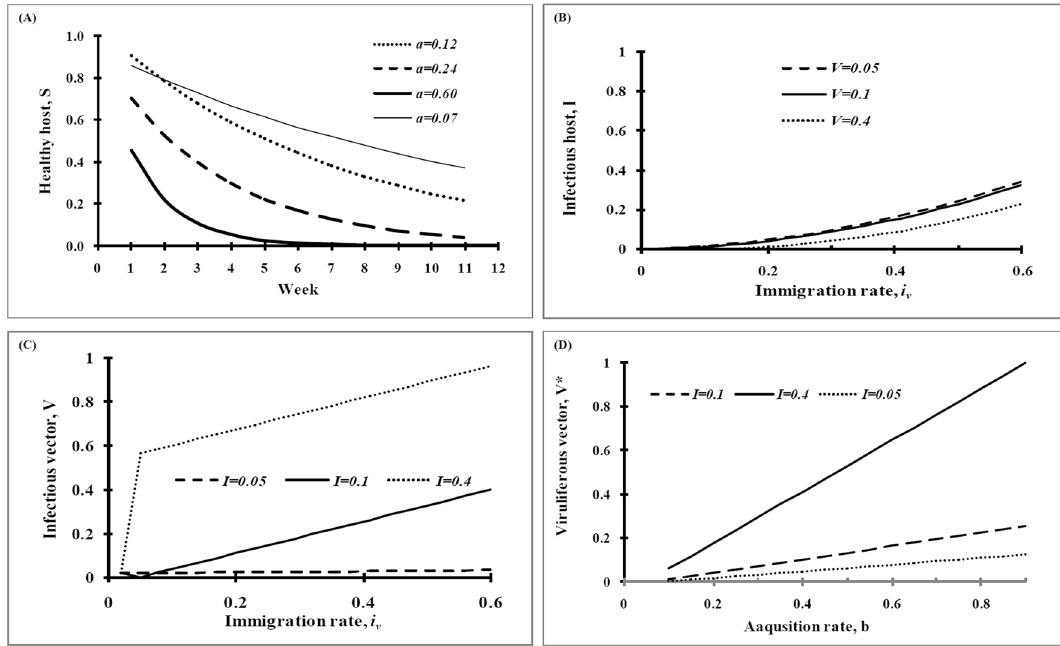
Figure 3. Parameter sensitivity on host and viruliferous whitefly population; A = transmission rate on healthy host; B = immigration rate on infectious host population; C = immigration rate on viruliferous vector and D = acquisition rate on viruliferous vector population.